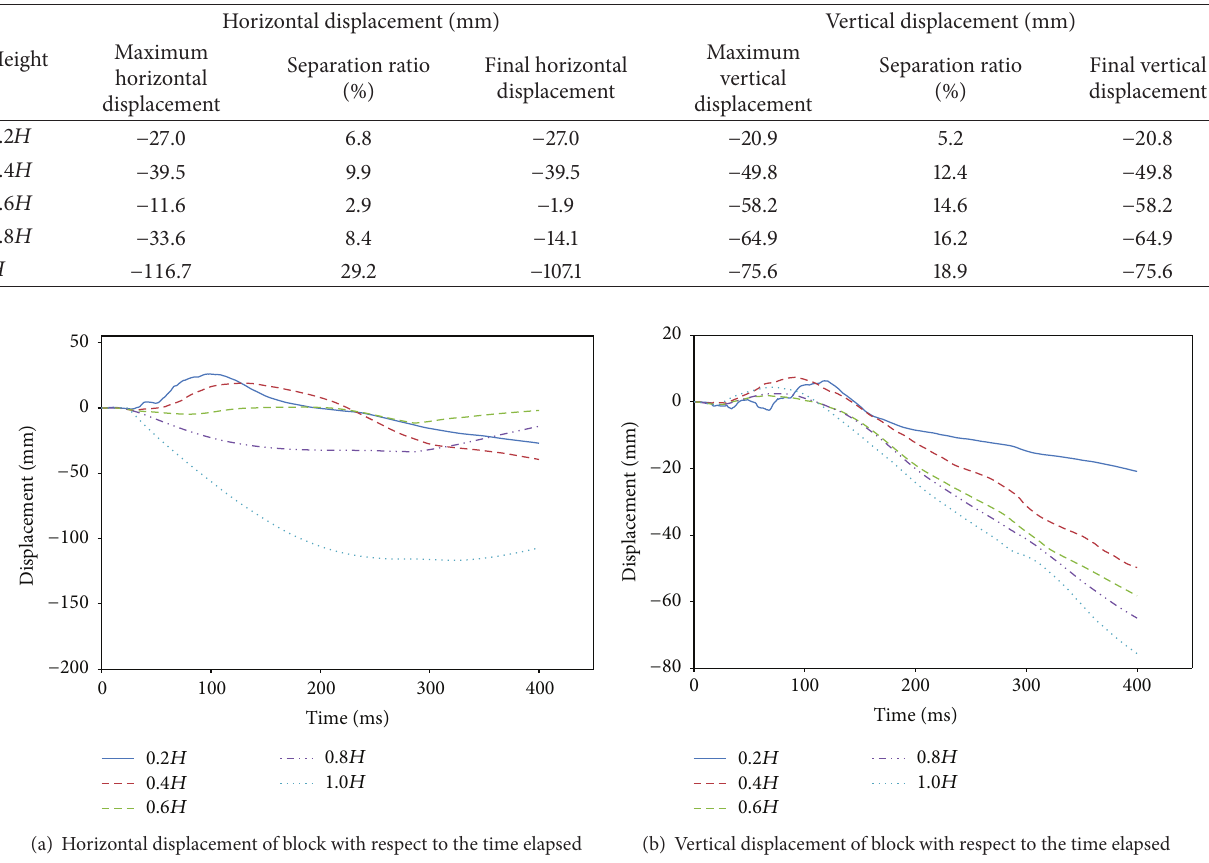
Table 8: Block displacement for 600 mm reinforcement spacing.